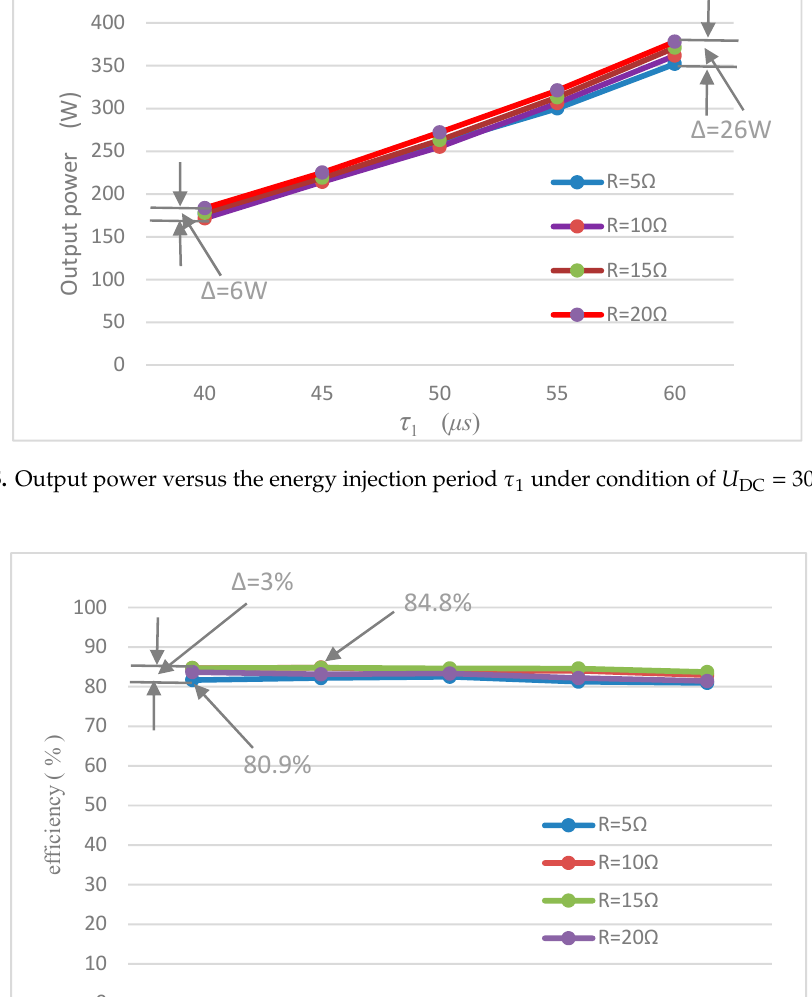
T im1 Figure 17. Experimental results of soft switching condition of IIEIFR converter.